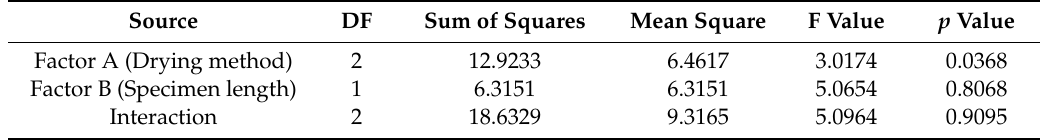
Table 6. Two-way analysis of variance with moisture